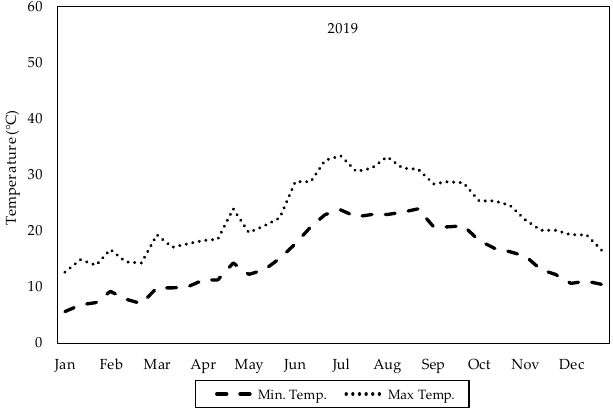
Figure 7. Temperature trend during the test period in ExpA_2.